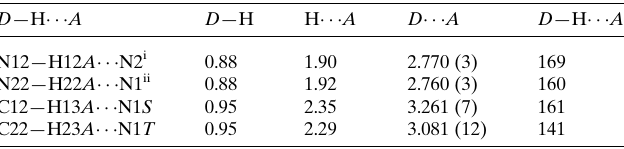
Table 4 Hydrogen-bond geometry (A˚ , (cid:5) ) for 2